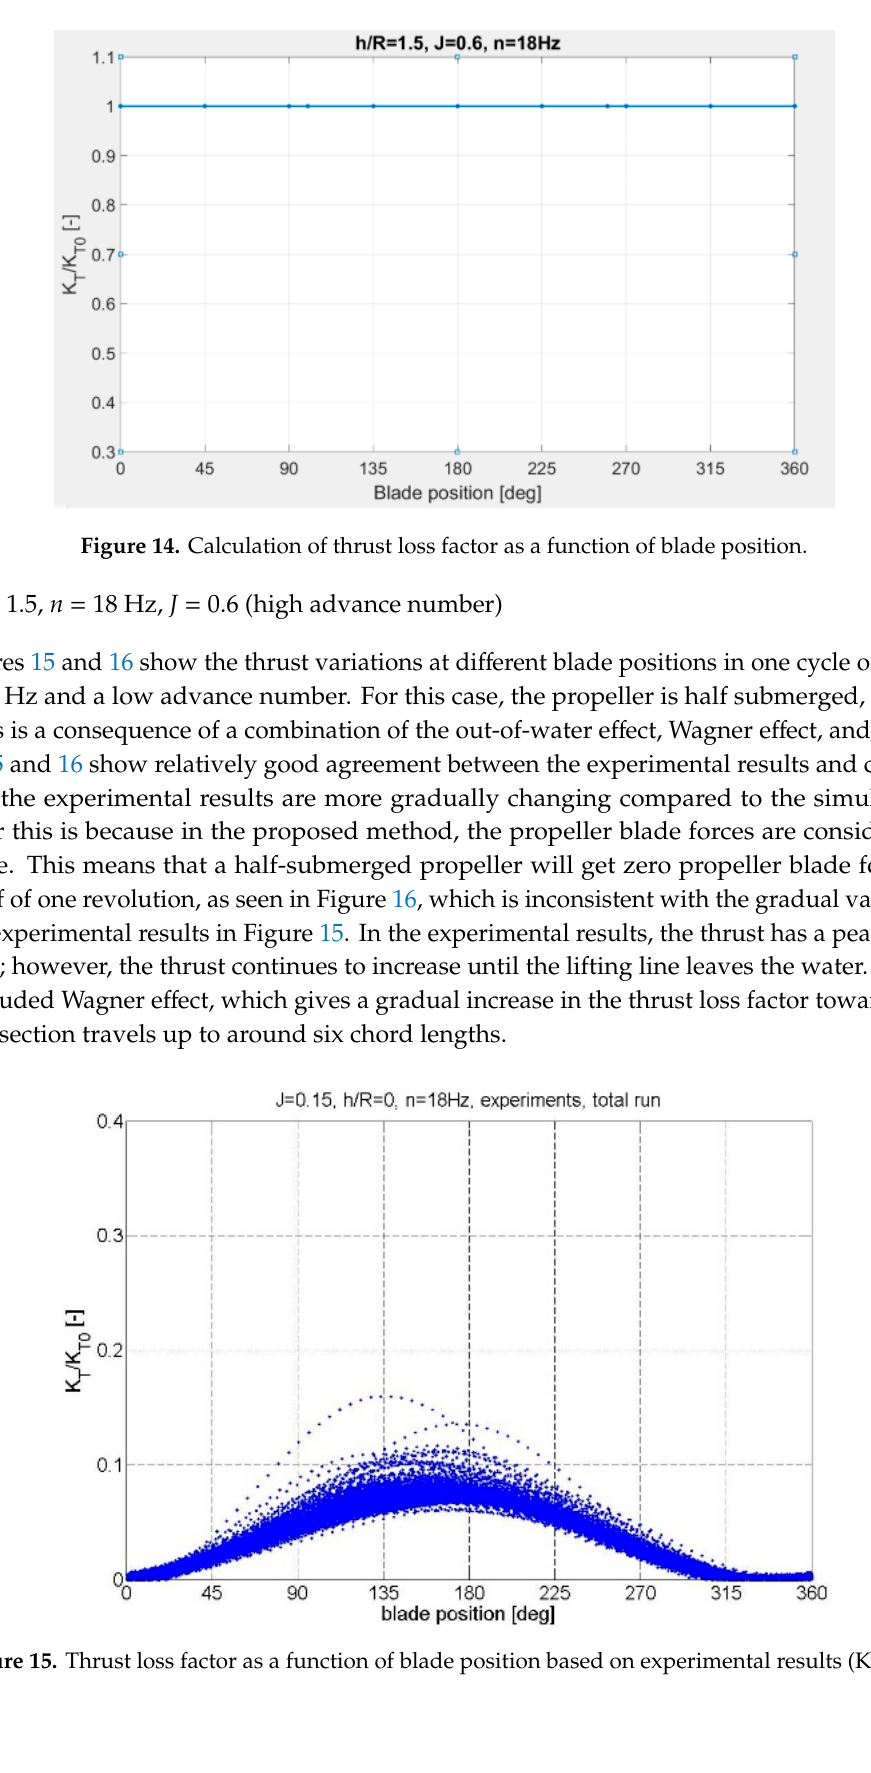
Figure 13. Thrust loss factor as a function of blade position red markers correspond to CFD calculations, and blue markers correspond to experimental results ( Koz10 ).